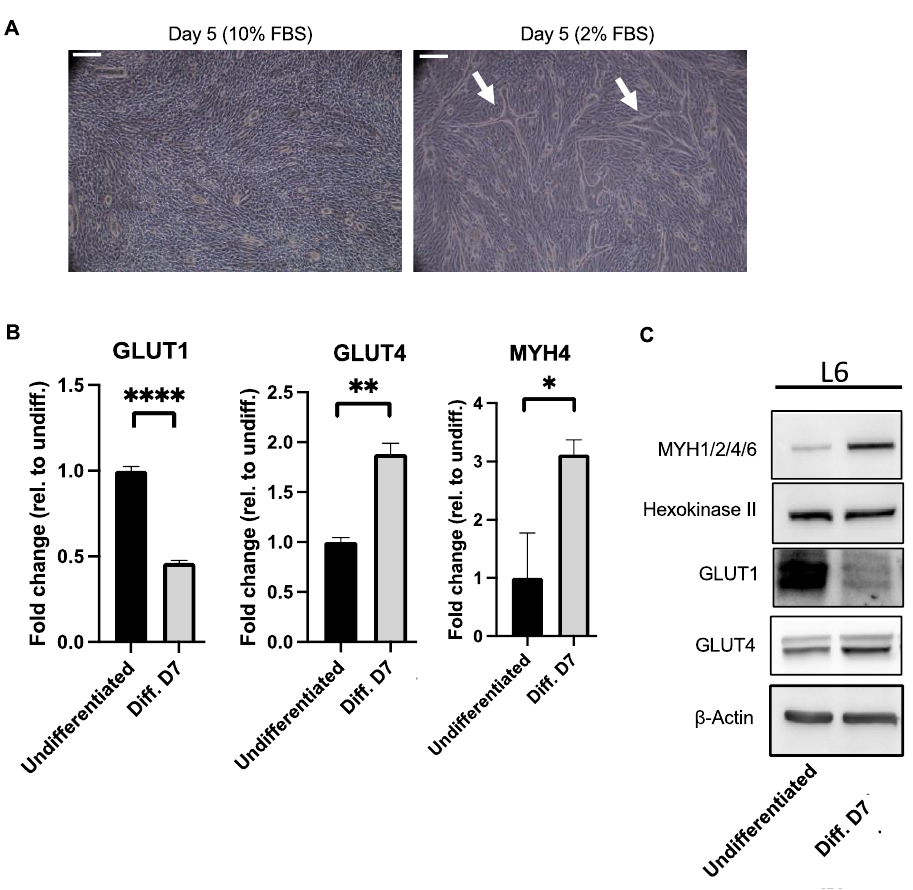
Figure 5. ( A ) L6 cells are differentiated in 2% fetal bovine serum media for 5 days. Myotubes structures are indicated with arrows. ( B ) Decreased RNA levels of Glut1 and increased RNA levels of Glut4 and Myh4 in differentiated L6 cells (Day 7) are found when these are compared to the undifferentiated cells. Expression is normalized to GAPDH . Values are expressed as the mean ± SEM. Statistical analysis is conducted by a Student’s t -test, * p < 0.05, ** p < 0.01, **** p < 0.0001. ( C ) Immunoblot results are showing increased levels of Type II marker MYH1/2/4/6 and Glut4, decreased levels of Glut1 and unchanged levels of type I marker Hexokinase II in L6 lysates from differentiated L6 cells (Day 7) when these are compared to those of the untreated undifferentiated cells. Beta-actin was used as a loading